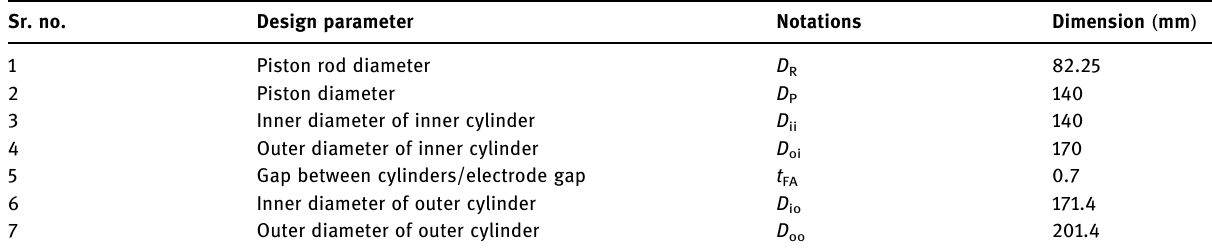
Table 1: Speci fi cations of designed ER damper Sr.